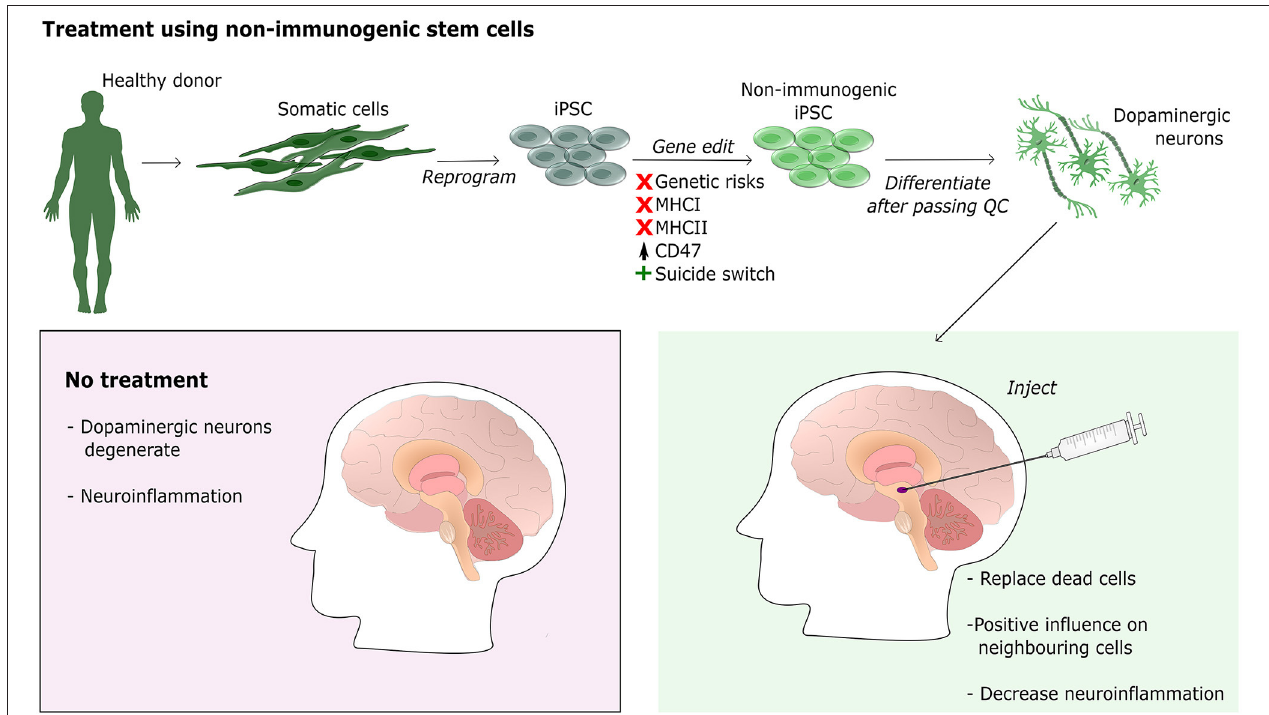
FIGURE 4 | Treatment of PD using non-immunogenic stem cells. The illustration shows the workflow for generating neural progenitor cells for transplantation into the striatum of a PD patient. A healthy donor provides a biopsy, preferably skin, which is then reprogrammed into iPSC using a non-integrative method. iPSC are then gene edited using CRISPR-Cas9 to generate non-immunogenic stem cells by knocking out MHCI, MHCII, and upregulating CD47. Furthermore, a suicide switch is inserted for safety regulation. Once the non-immunogenic cells pass quality control (QC) they can be differentiated into the required cell type, for PD dopaminergic neural progenitor cells. Cells are then injected into the striatum where they can differentiate and integrate. Integrated cells are expected to not only replace dead cells but also to positively influence neighboring cells and decrease